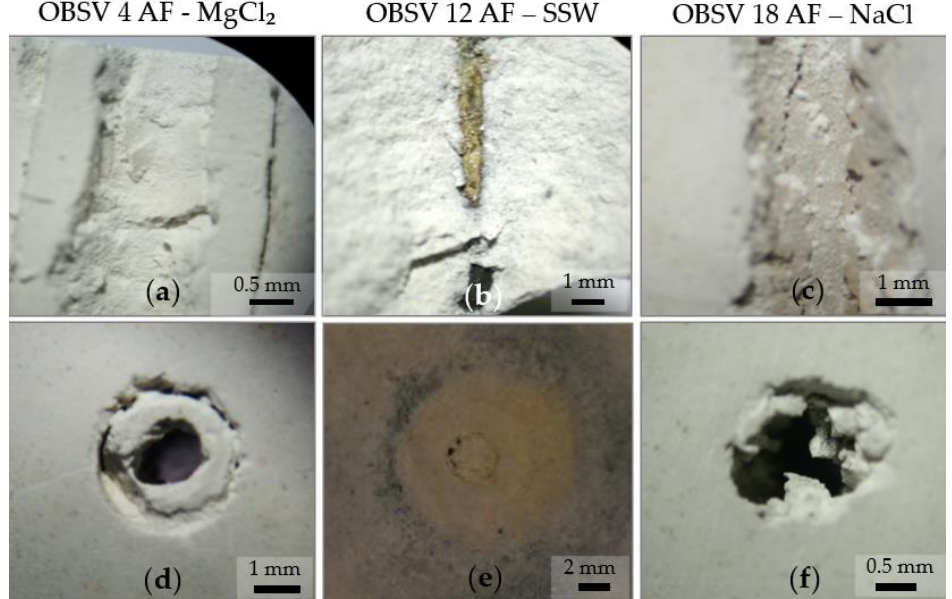
Figure 6. Photographs of textural characteristics of the three artificially fractured cores: ( a ) OBSV 4 AF-MgCl 2 #4 parallel to flooding direction. ( b ) OBSV 12 AF-SSW #5 parallel to flooding direction. ( c ) OBSV 18 AF-NaCl #1, parallel to flooding direction. The black arrow points to beige surface of the fracture precipitate. ( d ) OBSV 4 AF-MgCl 2 #1 perpendicular to flooding direction. Black arrow points to the void space between matrix and fracture precipitate. ( e ) Wet condition of OBSV 12 AF-SSW #1 perpendicular to flooding direction. ( f ) OBSV 18 AF-NaCl #3 perpendicular to flooding direction.